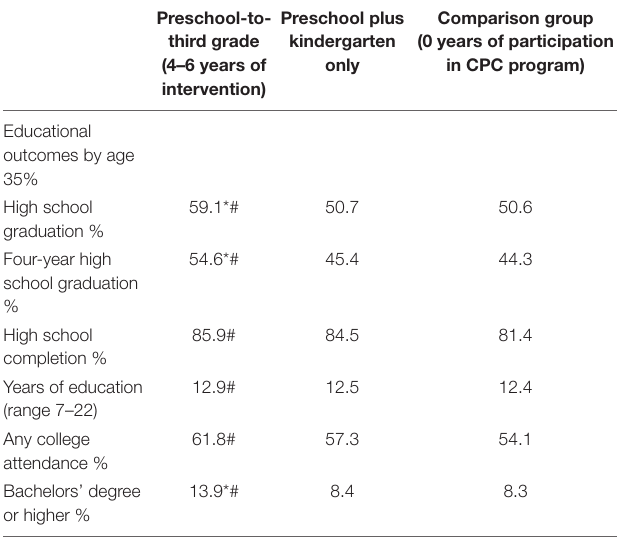
TABLE 1 | Predicted rates of educational attainment at age 35 in the Chicago Longitudinal Study. Preschool-to- third